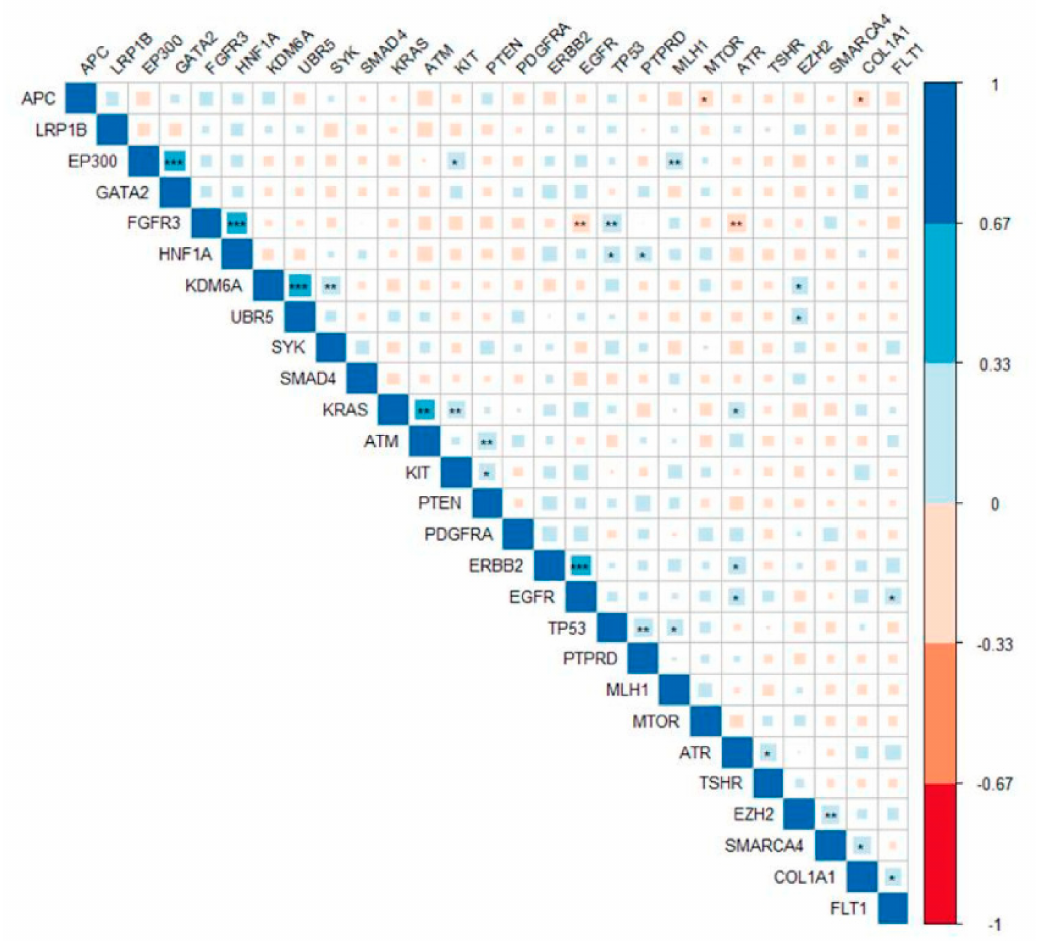
Figure 5. Correlation between mutated genes. The Pearson correlation between presence of a tissue-specific pathogenic variant between genes. Significant correlations are noted with * for p -values < 0.05, ** for p -values < 0.01, and *** for p -values less than 0.001. Color and size of the square denotes the value of correlation as indicated in the bar